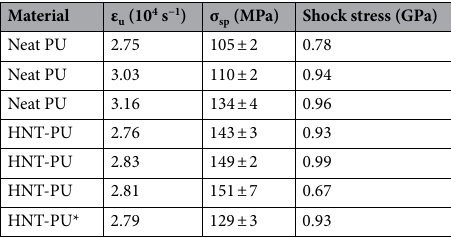
Table 1. Summary of the experimental spall